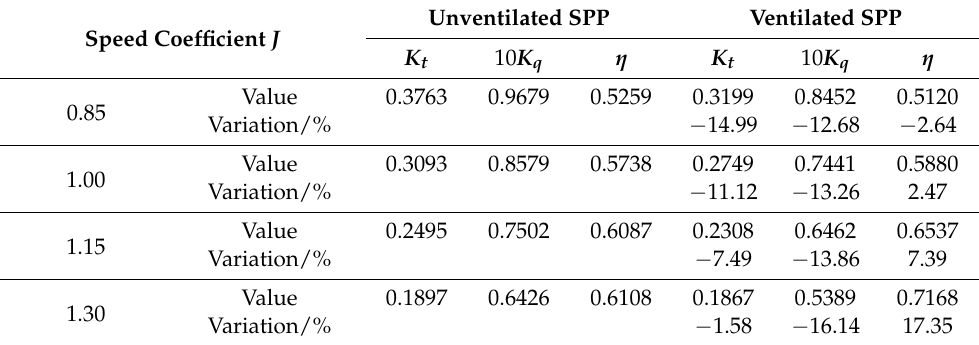
Table 4. Numerical results for the SPP under full submergence conditions.